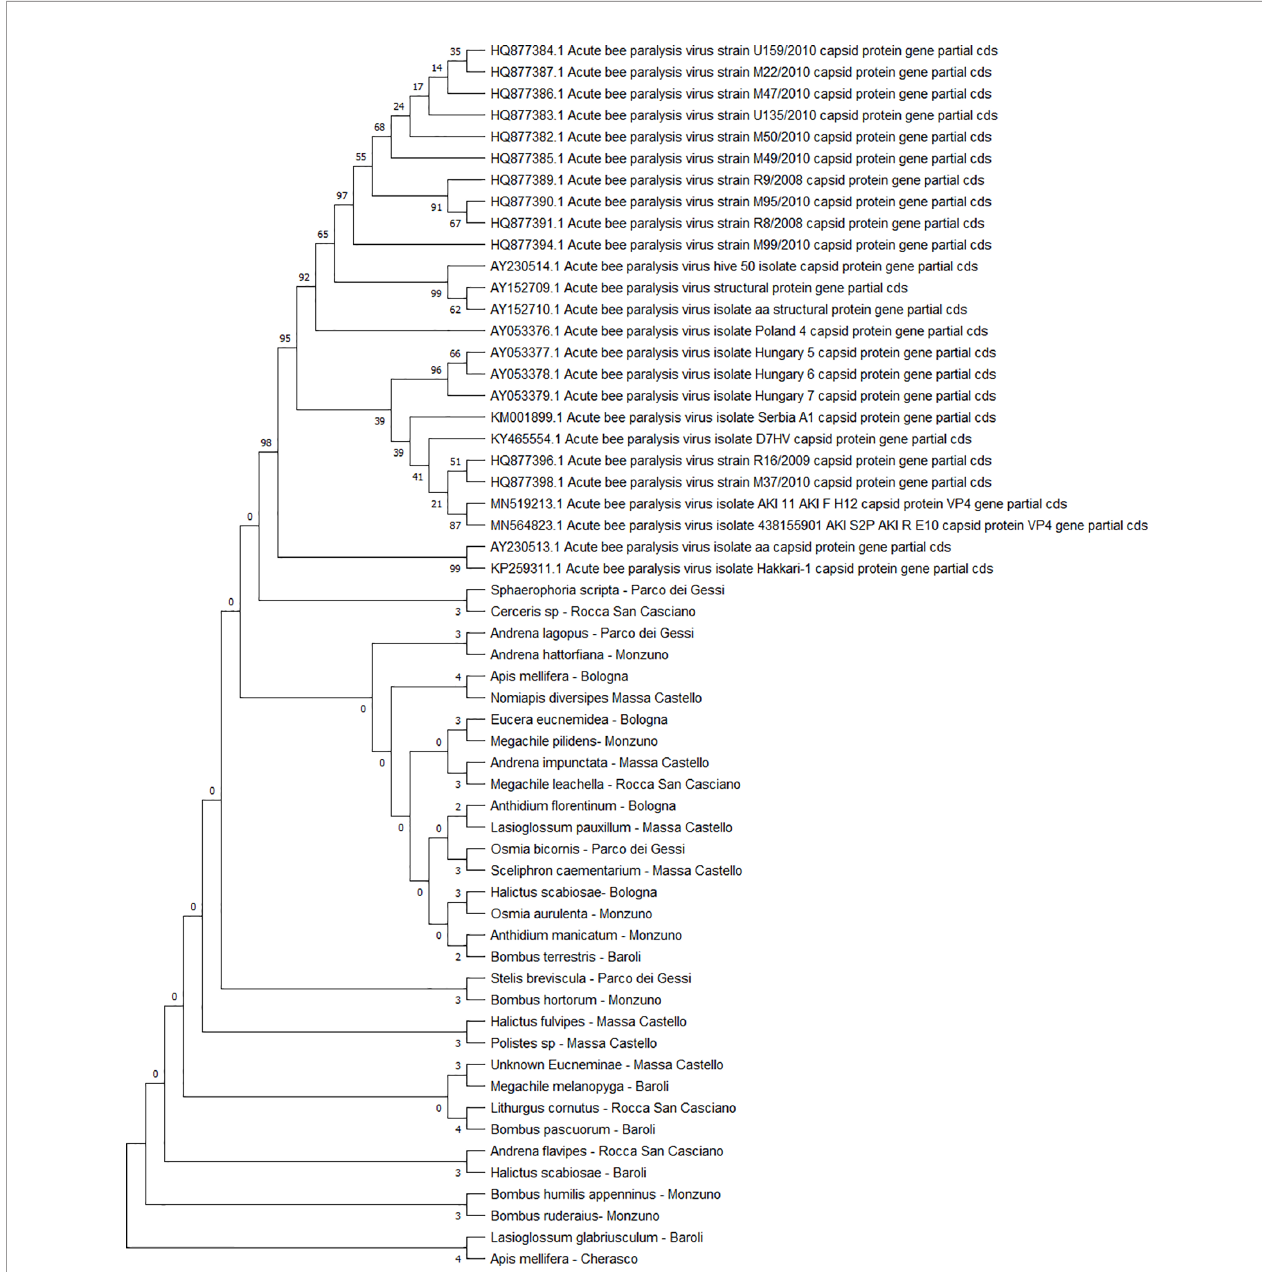
FIGURE 4 | Maximum likelihood nucleotide phylogeny of ABPV capsid protein gene. This analysis involved 57 nucleotide sequences. There were a total of 879 positions in the fi nal dataset. Only those with bootstrap > 50% are reported. Species and sampling sites are reported for the sequences identi fi ed in this study. ABPV, acute bee paralysis